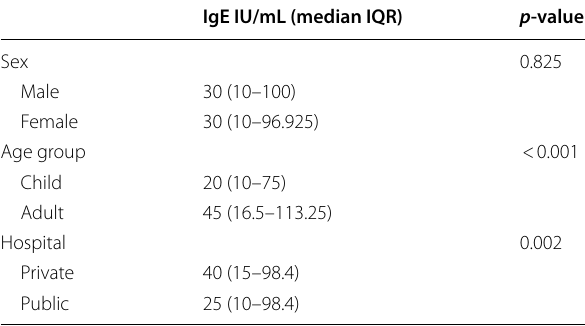
Table 2 Total IgE Levels among the different groups